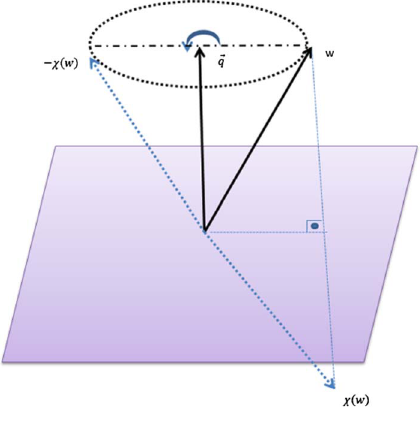
Figure 2. Re fl ection.